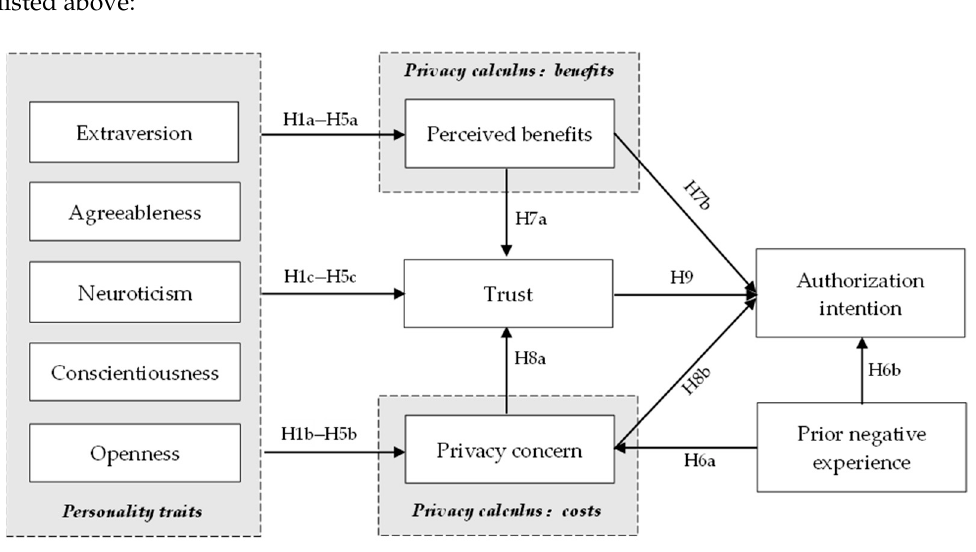
Figure 1. Conceptual